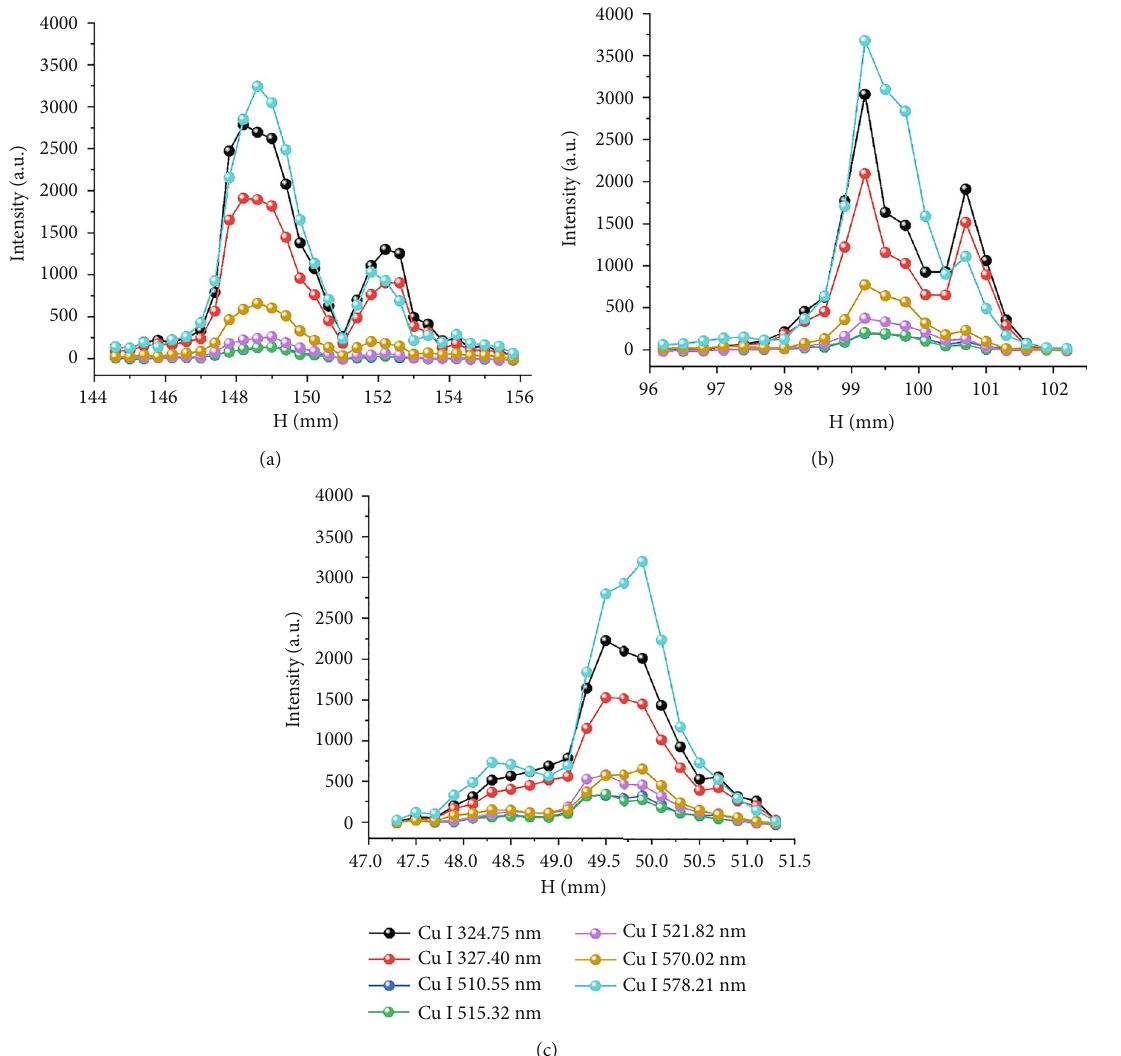
Figure 4: Graphs showing that the intensities of Cu atomic lines (i.e., Cu(I) at 324.75nm, 327.40nm, 510.55 nm, 515.32nm, 521.82nm, 570.02nm, and 578.21 nm) change with H , when using the lens L1 with a focus length of (a) 150mm, (b) 100mm, and (c) 50mm. The pulse energy is 20